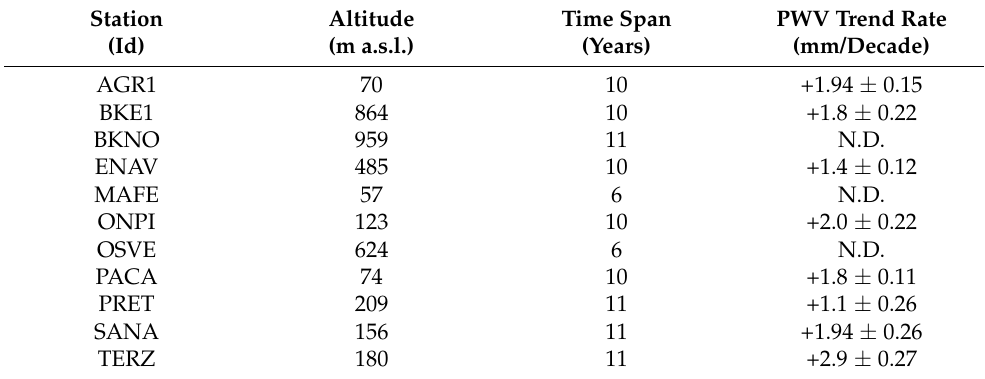
Table 3. PWV trends retrieved from the GAMIT/GLOBK analysis [33] applied on the decadal GPS data sets; it was not possible to determine the trend for BKNO because data had different